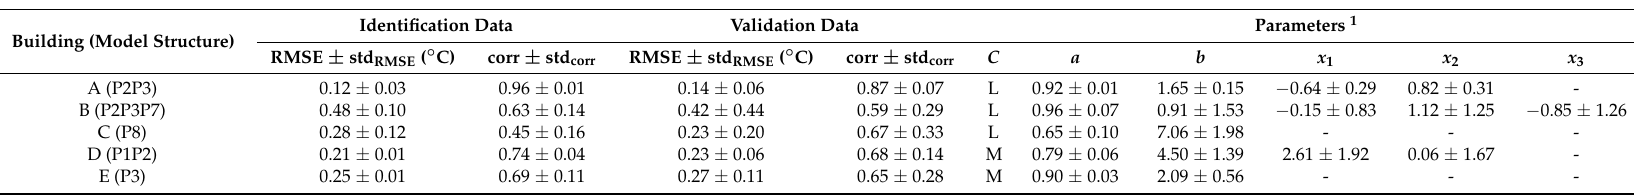
Table 5. Cross-validation results with mean RMSE and r and their standard deviation. RMSE and r values were calculated by averaging the values of four identification/validation data sets. Parameters are presented as average values with their standard deviation over four identification data sets.